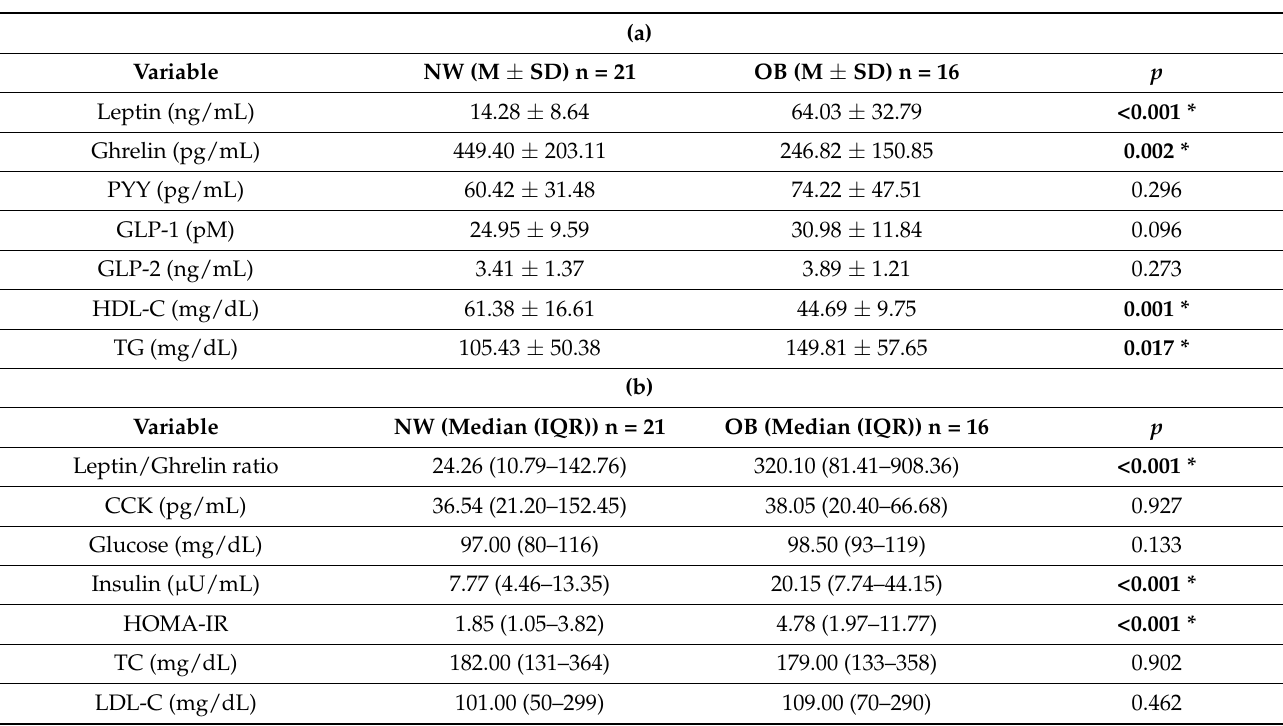
Table 2. ( a ) Biochemical and gut peptide analyses in normal weight vs. obese participants (mean ± SD for normally distributed data). ( b ) Biochemical and gut peptide analyses in normal weight vs. obese participants (median (IQR) for non-normally distributed